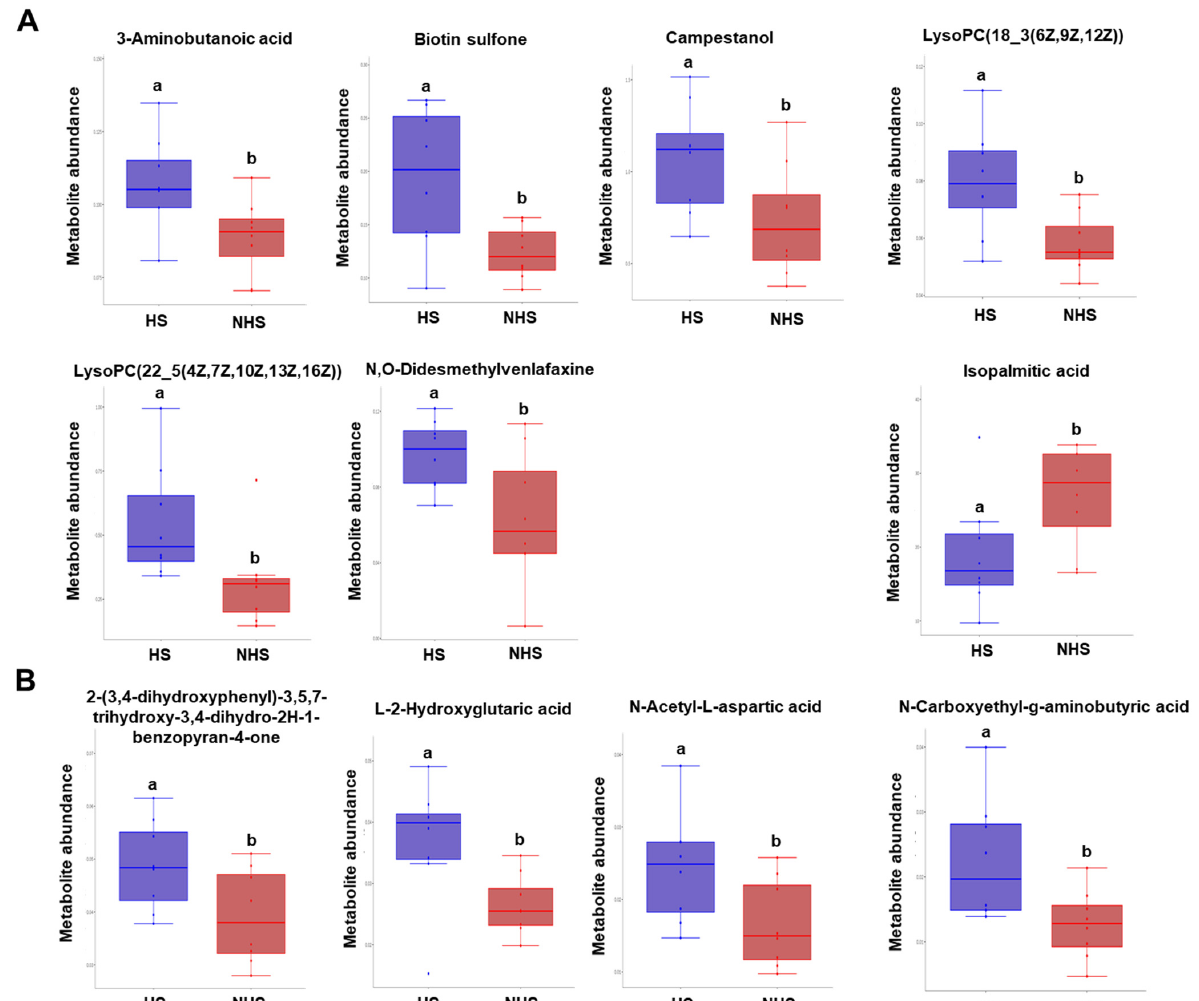
Figure 5. Verification of differential metabolites between HS and NHS groups. ( A ) Abundance of sperm metabolites in the positive ion mode between HS and NHS groups. The blue bars denote HS group, the red bars indicate NHS group. The metabolites identified in the positive ion mode included 3-aminobutanoic acid, biotin sulfone, campestanol, lysoPC(18_3(6Z,9Z,12Z)), lysoPC(22_5(4Z,7Z,10Z,13Z,16Z)), and N,O-Didesmethylvenlafaxine. The data are shown as mean ± S.E.M, and different letters on the bars indicate significant differences ( p < 0.05). ( B ) Abundance of sperm metabolites in the negative ion mode between HS and NHS groups. The blue bars denote HS group, the red bars indicate NHS group. The metabolites identified in the negative ion mode included isopalmitic acid, 2-(3,4-dihydroxyphenyl)-3,5,7-trihydroxy-3,4-dihydro-2H-1-benzopyran-4-one, L-2-Hydroxyglutaric acid, N-Acetyl-L-aspartic acid, and N-Carboxyethyl-g-aminobutyric acid. The data are shown as mean ± S.E.M, and different letters on the bars indicate significant differences ( p < 0.05).